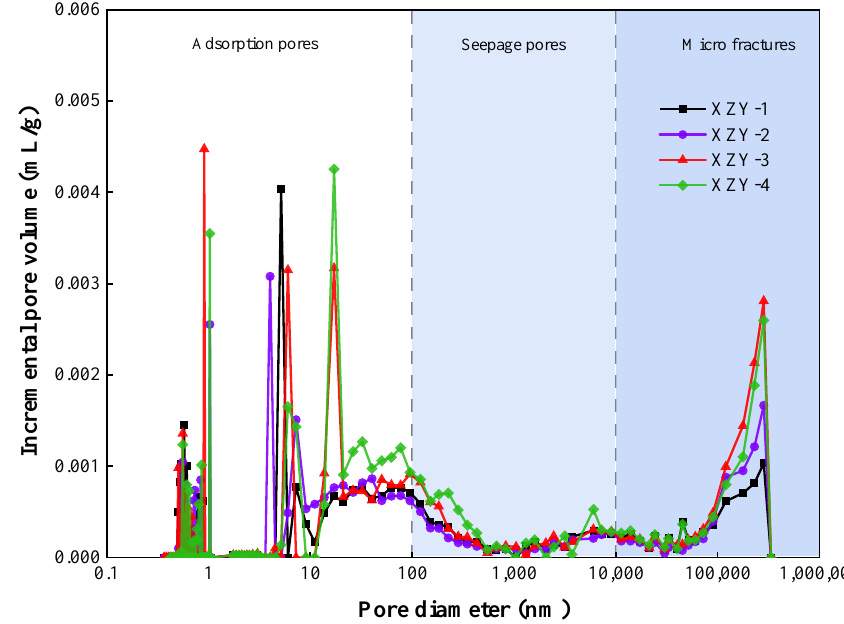
Figure 5. The pore size distributions of coal samples.